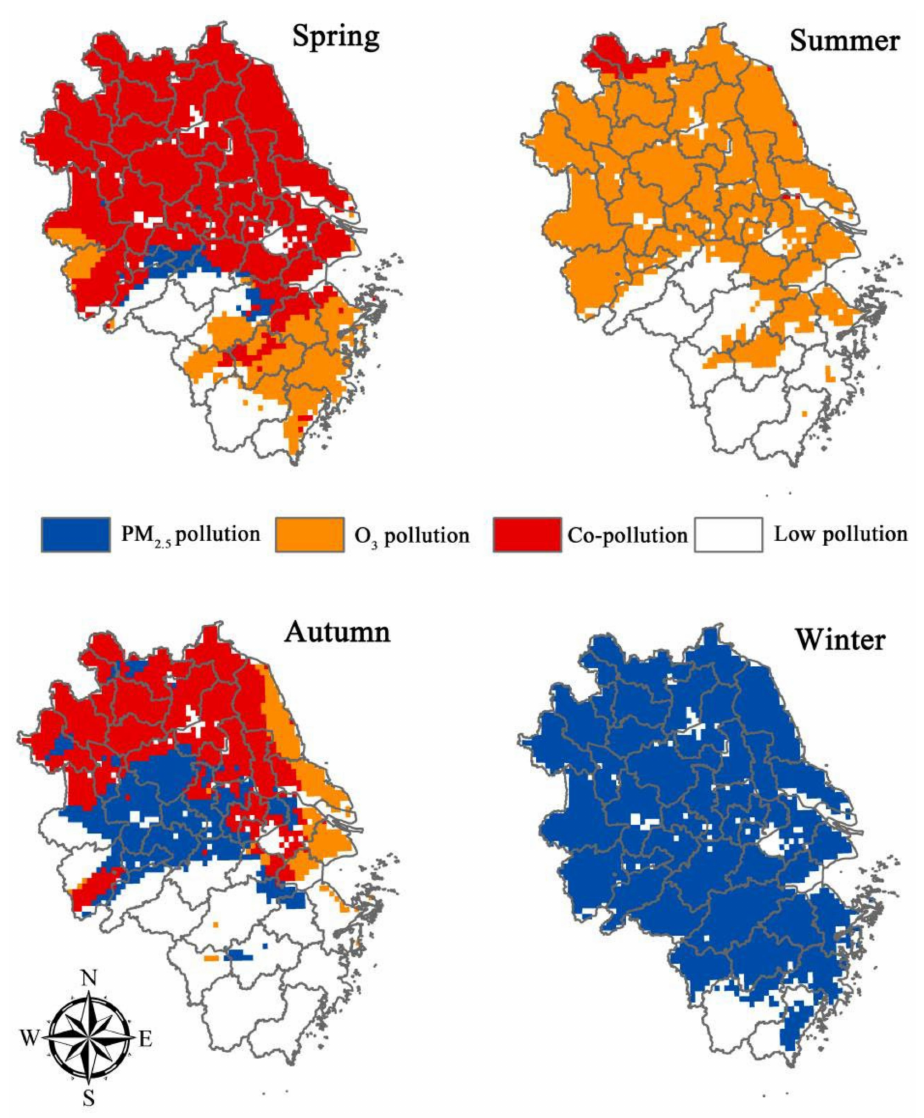
Figure 10. Seasonal spatial distributions of air pollution from 2015 to